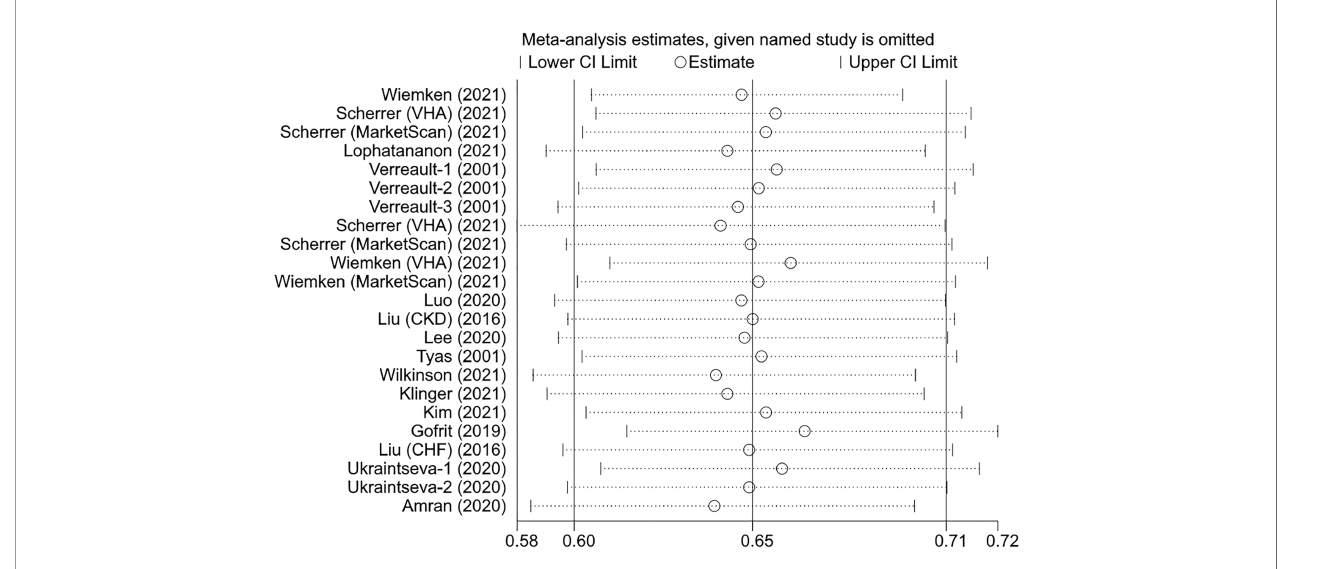
FIGURE 4 | The effects of the individual studies on the overall pooled